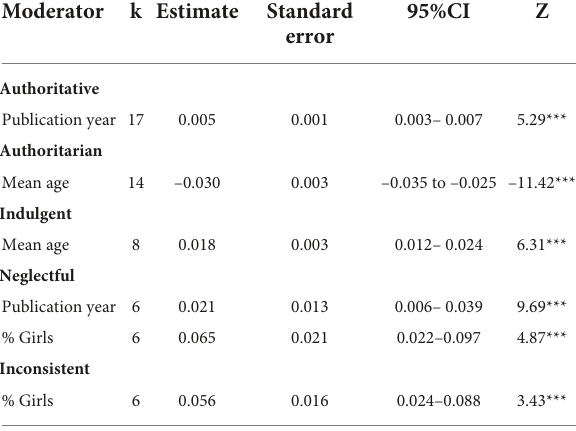
TABLE 5 Moderating effects of continuous